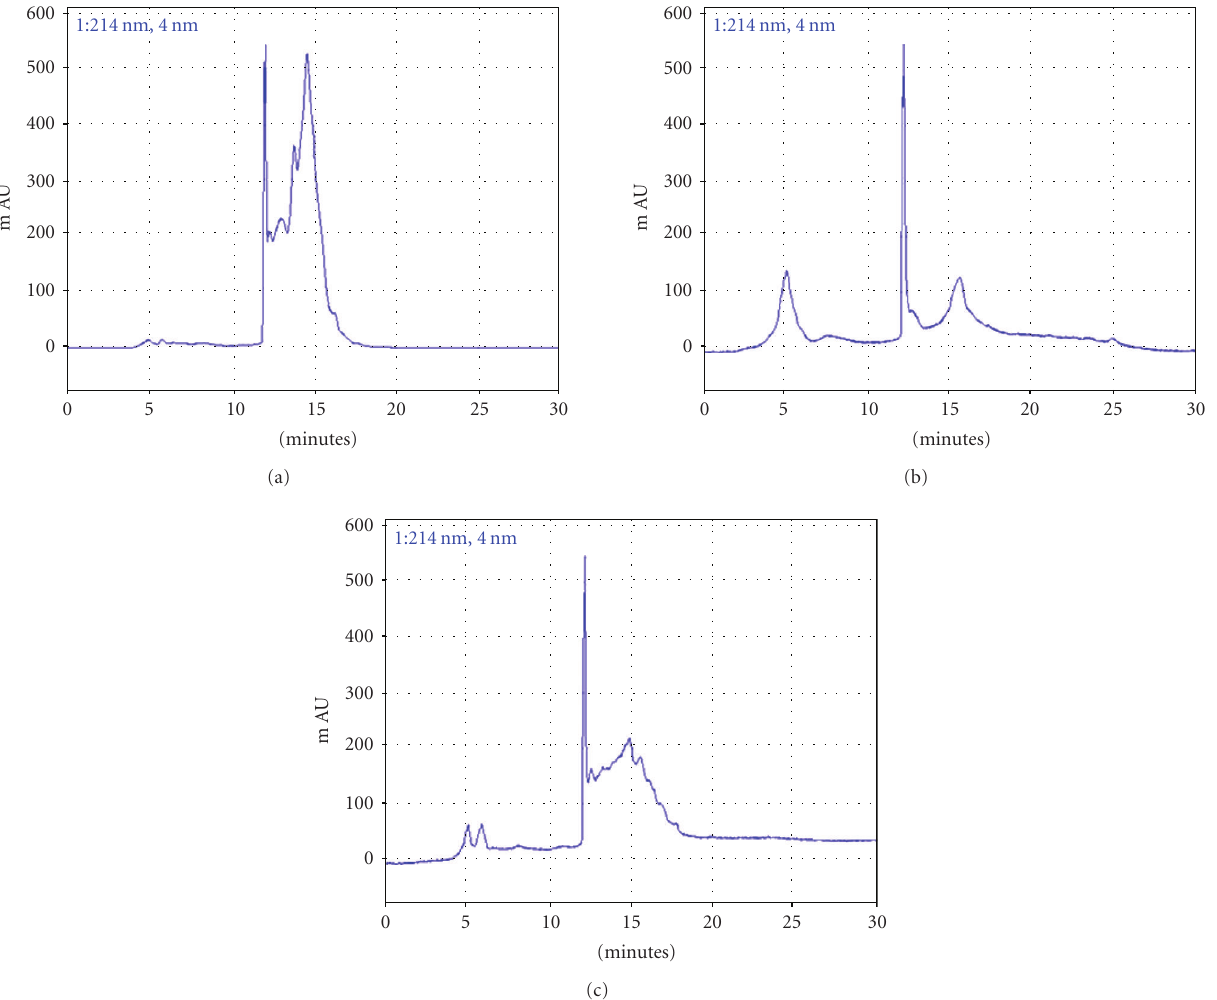
Figure 5: Chromatographic separation of the aqueous extracts of crude (a) PT, (b) CR and (c) their combinational prescription, respectively. Because most of the peaks were eluting within the first 30 minutes, the chromatograms are the displays of the up to 30